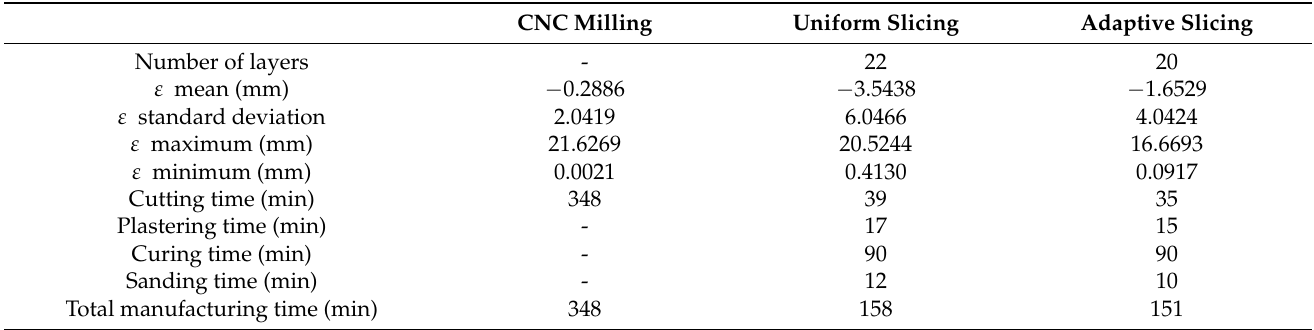
Table 4. The error obtained by measuring the actual production result with a measuring instrument and the time